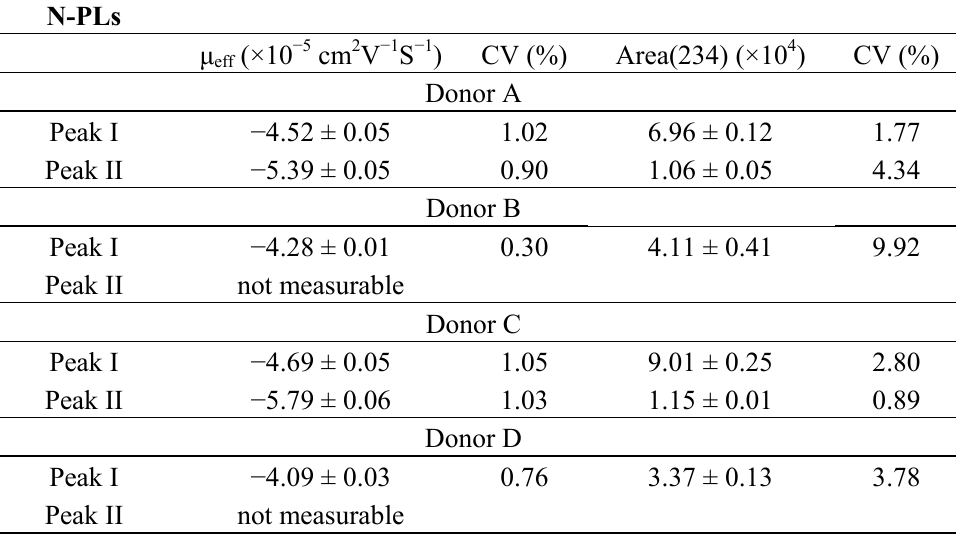
Table 8. The average effective mobility and peak area of native VLDL phospholipids analyzed by MEKC at absorbance 234 nm (data are means ± SD of four replicates).